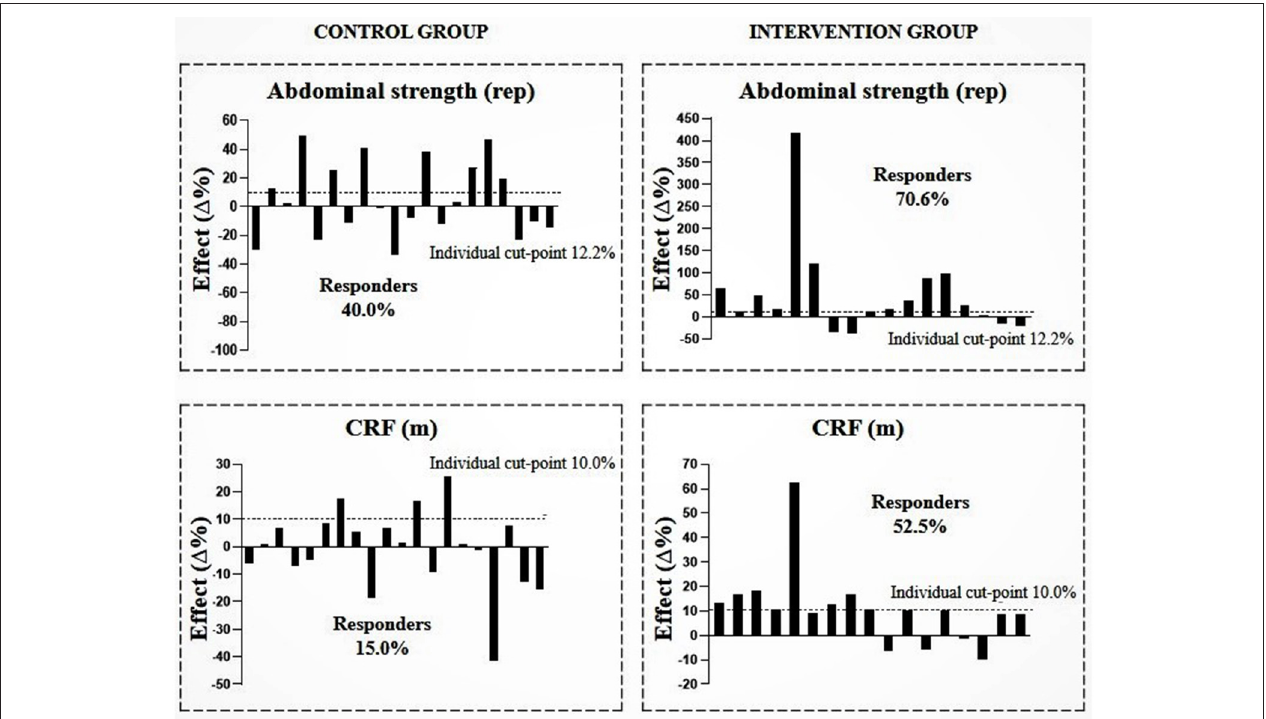
FIGURE 3 | Prevalence of responders in the intervention and control group after multicomponent intervention for abdominal strength and cardiorespiratory fitness (CRF). CG, n = 20; IG, n = 17. The analyses were adjusted for sex, age, and sexual